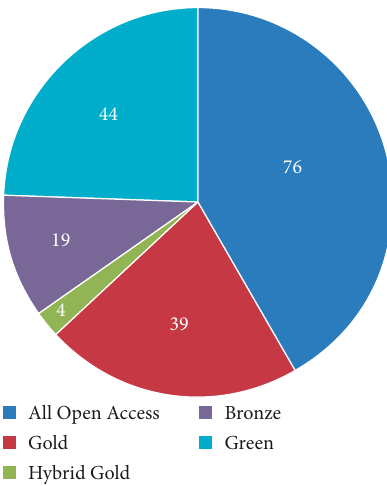
Figure 7: Journal distribution.